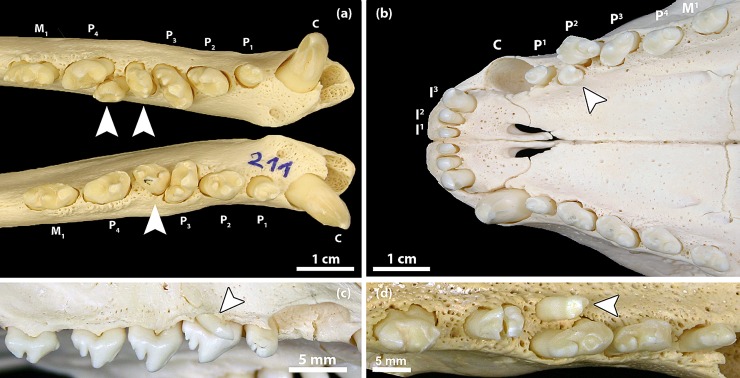
Examples of supernumerary teeth in the permanent dentition of Eastern Atlantic harbor seals (Phoca vitulina vitulina).(a) Dorsal view of the mandibular tooth rows of a 2-year-old female (specimen ZIK 24806). There are two supernumerary teeth (located between P3 and P4) in the left and one supernumerary tooth in a corresponding position of the right mandible (arrowheads). Due to the formation of the supernumeraries, both teeth at the normal P3 position are rotated approximately 45 degrees. The condition is interpreted as the result of a splitting of both the P3 and the P4 tooth germs on the left side and of the P3 tooth germ on the right side. (b) Ventral view of maxillary and incisive bones of a 3-year-old female (specimen ZIK 28942) showing a (two-rooted) supernumerary tooth (arrowhead) situated palatal to the left P2. The cause of the hyperodontia is most probably a splitting of the P2 tooth germ. (c) Lateral view of the right maxilla of a 1-year-old male (specimen ZIK 28170), showing a peg-shaped and mesially inclined supernumerary tooth (arrowhead) located buccal to the P2 (mesial to the right). (d) Ventral view of left maxilla of a 10-year-old female (specimen ZIK 29485), showing a peg-shaped, mesially inclined supernumerary tooth (arrowhead) located palatal to the P3 (mesial to the right).